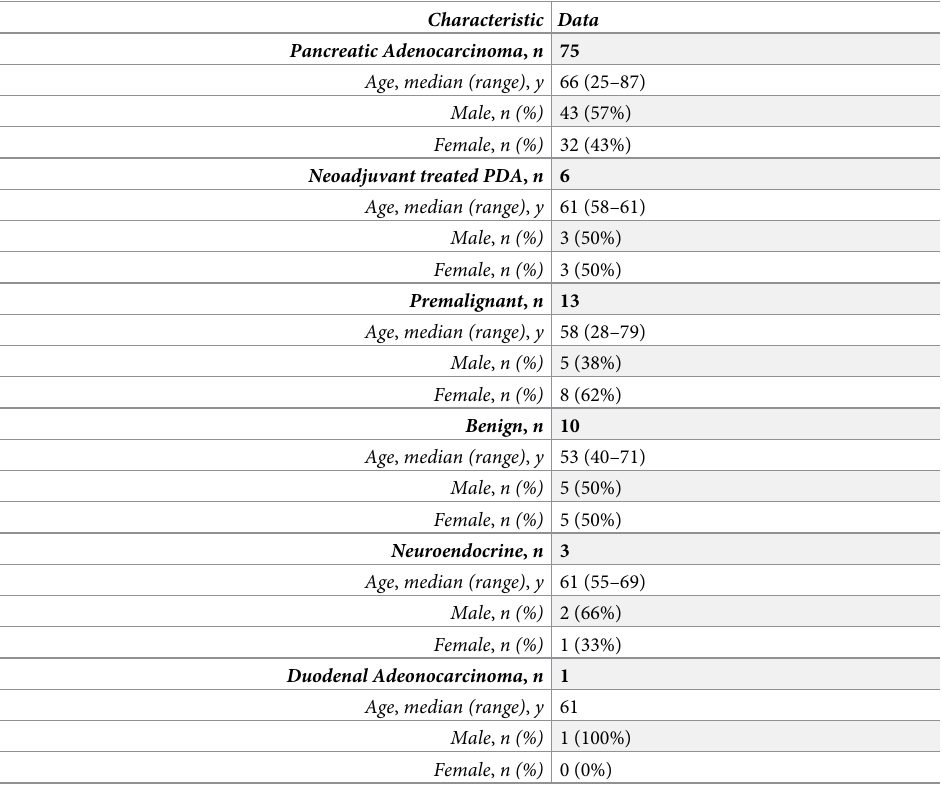
Table 1. Demographics of patients on the